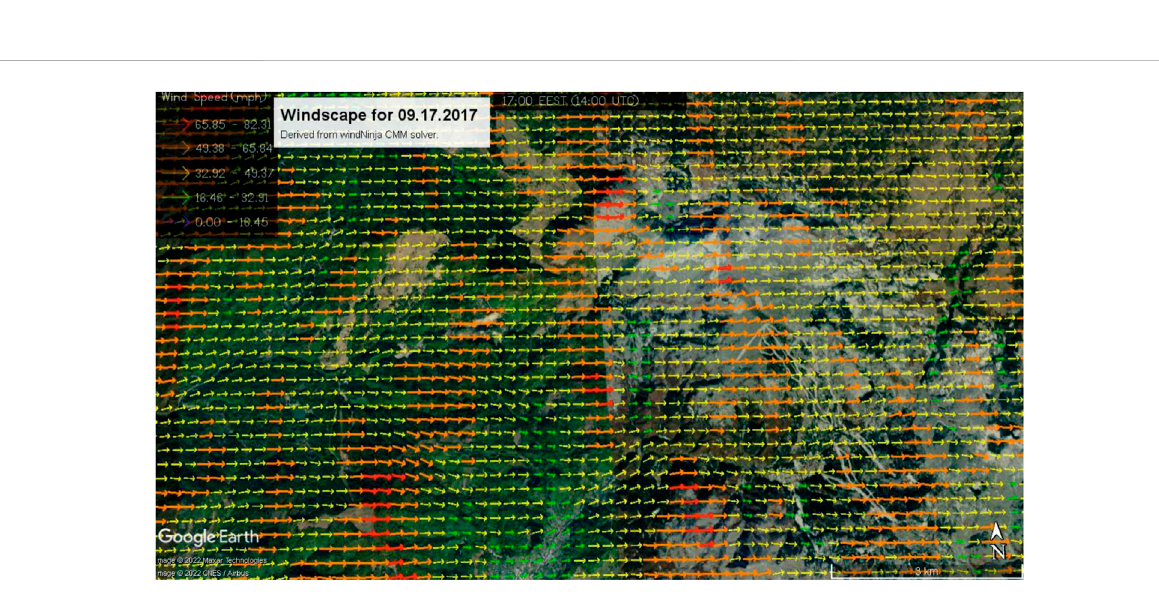
FIGURE 8 Initial CFD model of the storm on 17.09.2017, derived from the WindNinja dataset for Google